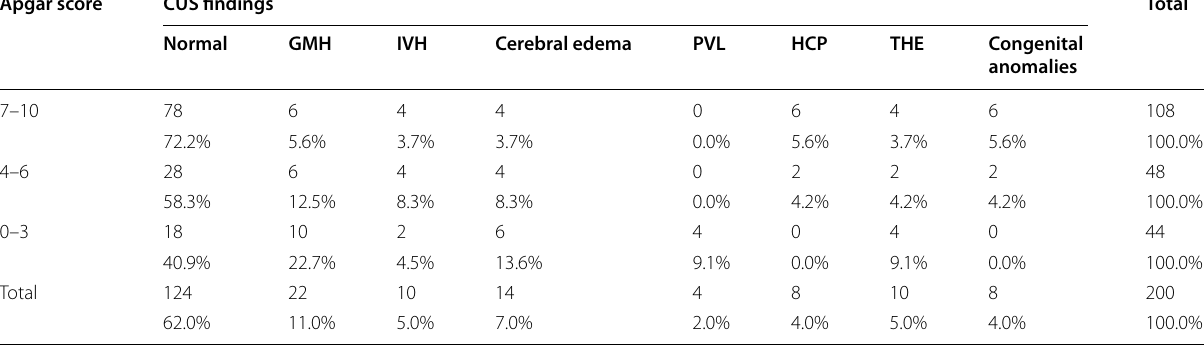
Table 4 Distribution of various CUS findings with Apgar score Apgar score